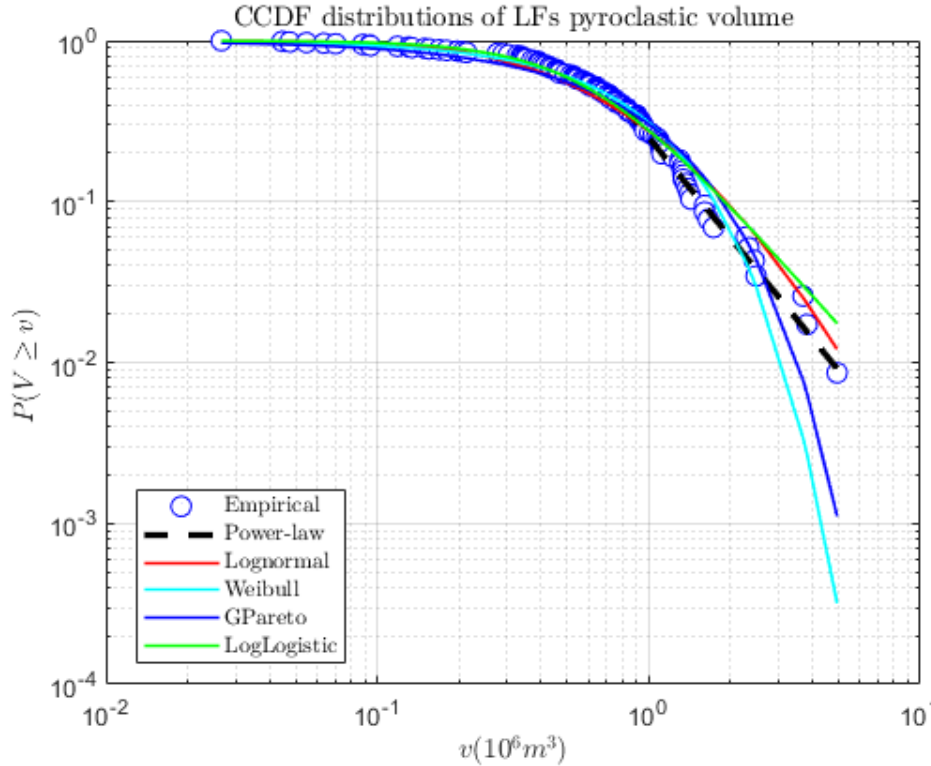
Figure 9. Log-log plot of the empirical complementary cumulative distribution function CCDF of lava fountain pyroclastic volume and the five considered probability distribution models. Table 5. Negative log likelihood of the compared models for the pyroclastic volume dataset.